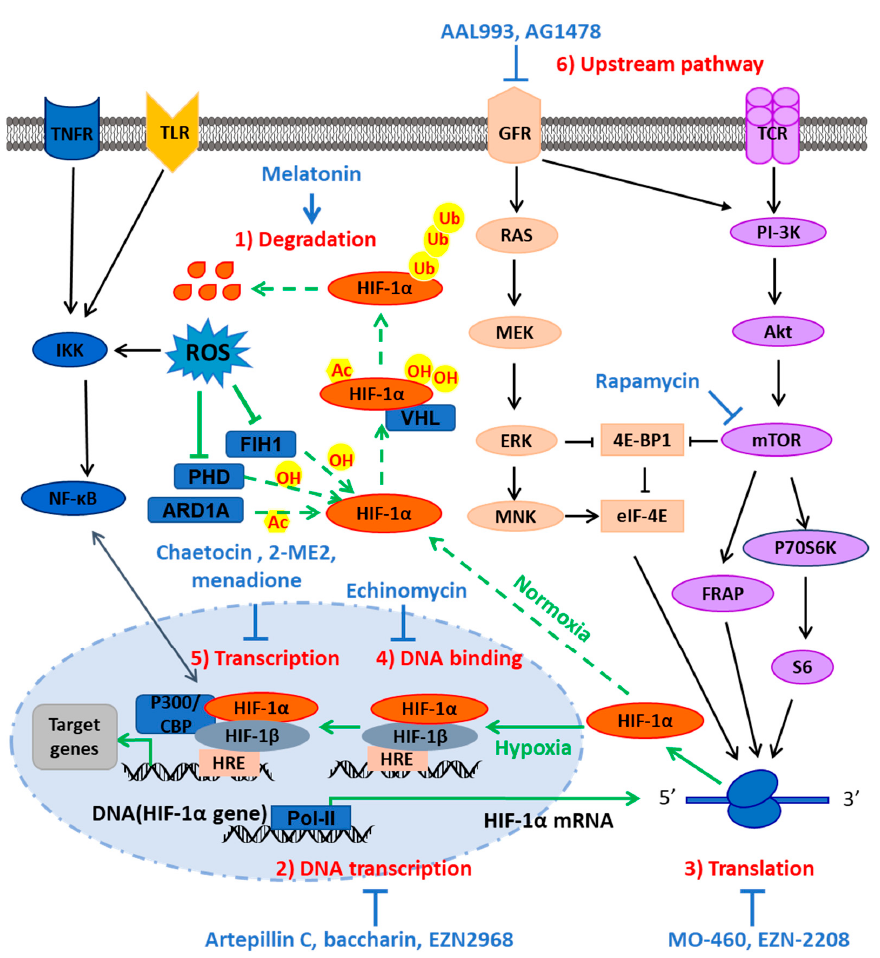
Figure 2. The signaling pathways of HIF-1 α inhibitors and their actions. HIF-1 α inhibitors mainly inhibit HIF-1 α activity through the following mechanisms: (1) influence the degradation of HIF-1 α ; (2) inhibit the DNA transcription and expression of HIF-1 α ; (3) block the translation activity of mRNA; (4) hinder HIF-1 α binding with HRE; (5) impede the formation of HIF-1 α transcription complex; and (6) inhibit HIF-1 α upstream pathway. Dashed arrows indicate the response under normoxia, solid arrows indicate the response under hypoxia, green arrows indicate the regulation mechanism of HIF-1a self-activity, and black arrows indicate the regulation mechanism of signaling pathway.